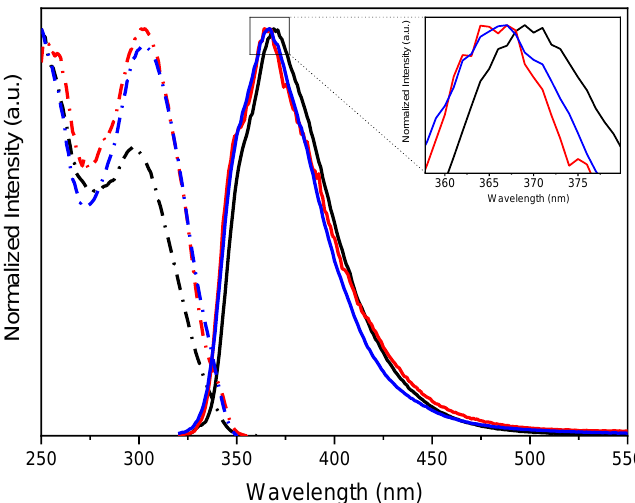
Figure 1. Normalized photoluminescence, PL, emission (continuous lines) and excitation (dashed – dotted lines) spectra of TT-HThio . DCM (1 × 10 − 5 M) at 298 K (black) and 77 K (red); λ exc = 300 nm, λ em = 370 nm. PMMA film (0.5% wt) at 298 K (blue); λ exc = 300 nm, λ em = 365 nm. Crystals of TT-HThio show, both at 298 ( = 26%) and 77 K, an excitation-dependent PL behavior comprising one fluorescence and two phosphorescences (Figure 2). In partic- ular, at 298 K, one fluorescence at λ em = 376 nm (FL, = 1.15 ns, Figure S7) is observed by exciting at 300 nm, one high-energy phosphorescence (HEP, with vibronic replica at λ em = 425 and 451 nm, = 5.91 ms, Figure S8) is visible by exciting at 376 nm and one low-energy phosphorescence (LEP, at λ em = 497, 530 and 578 nm, = 50.22 ms, Figure S9) appears when exciting at 450 nm. At 77 K, the three components are better resolved vibronically, in al- most the same positions but with longer lifetimes with respect to those measured at room temperature (FL, λ em = 368 nm, = 1.48 ns; HEP, λ em = 420 and 448 nm, = 10.61 ms; LEP, λ em = 494, 533 and 577 nm, = 132.01 ms, Figures S10, S11 and S12, respectively). Intri- guingly, the corresponding excitation profiles are characterized at low energy by three contributions recognizable at both 298 and 77 K. Specifically, one low-energy state (332, 354 nm at 298 K and 335, 347 at 77 K) assigned to singlet molecular excited state S 1 in agreement with structural and theoretical studies (see later), one triplet excited state of molecular origin (389 nm at 298 K and 390, 403 nm at 77 K), T mol , and one triplet excited state of aggregate origin (446 nm at 298 K and 448, 471 nm at 77 K), T ag , are observed. A mirroring relationship with the corresponding emission is clearly visible at 77 K. Figure 2. Normalized PL emission (continuous lines) and excitation (dashed – dotted lines) spectra of crystals of TT-HThio : ( a ) 298 K, emission at λ exc = 300 nm (black), 376 nm (blue), 450 nm (red), excitation at λ em = 376 nm (black), 426 nm (blue), 532 nm (red); ( b ) 77 K, emission at λ exc = 300 nm (black), 368 nm (blue), 448 nm (red), excitation at em = 368 nm (black), 420 nm (blue), 533 nm (red). Based on the observation that increases from 11%, in diluted DCM solution, to 26%, measured for TT-HThio crystals, we hypothesized possible aggregation-enhanced emis- sive (AEE) features; therefore, solvent (THF)/non-solvent (water) experiments have been performed. Addition of increasing water fractions to TT-HThio in THF (keeping the con- centration equal to 1 × 10 − 5 M) results, instead, in emission quenching (Figure 3), indicating that aggregation itself is not sufficient to intensify luminescence, and that proper molecule organization (i.e. crystallization) is an indispensable condition to enhance emission from TT-HThio . Similarly, in TT itself, crystallization is a necessary condition to switch on lu- minescence [9]. 325